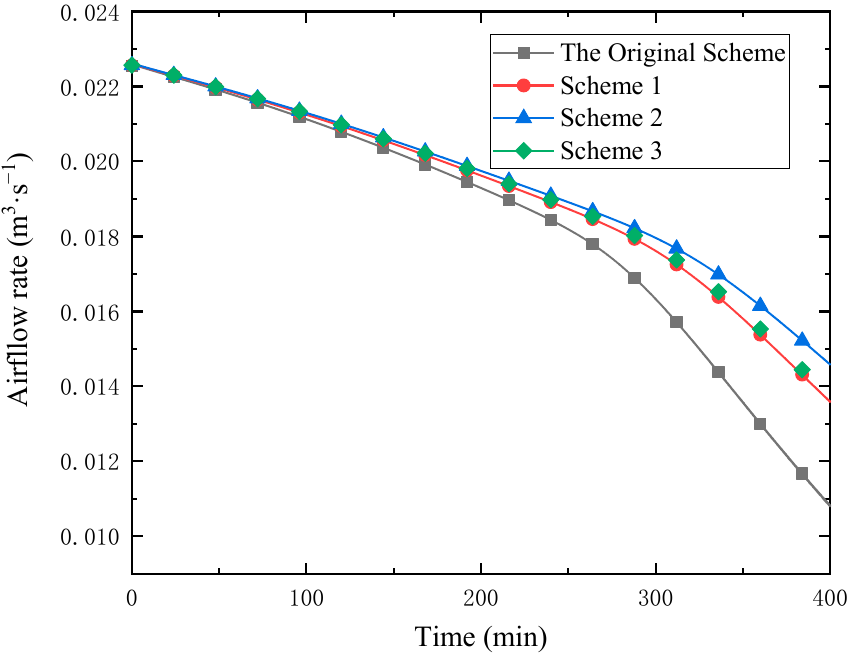
Figure 7. Airflow rate for three schemes during frosting 400 min duration.